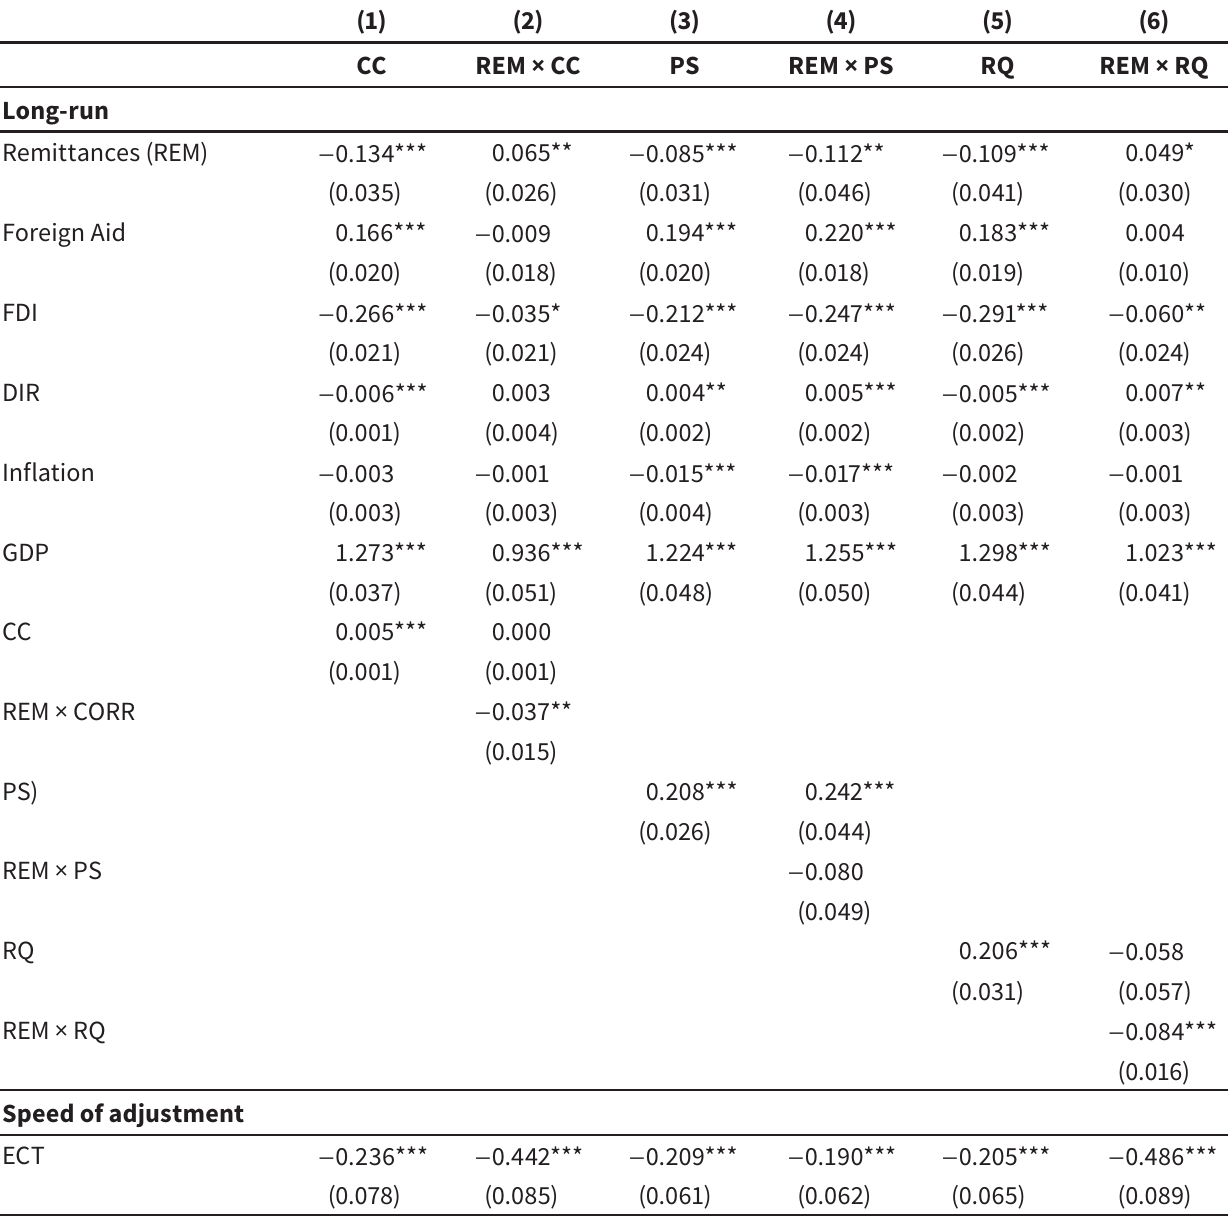
Individual governance indicators and